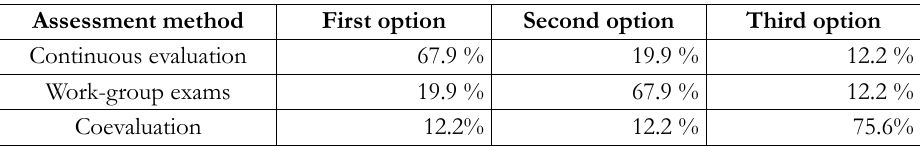
Table 1. Preferred Methods of